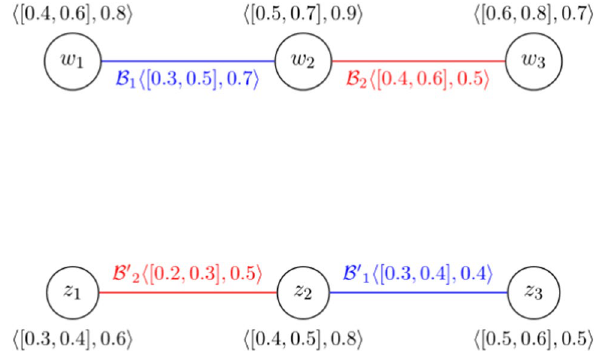
Fig. 2 CFGSs G = ( A , B 1 , B 2 ) and G � = ( A � , B � 1 , B � 2